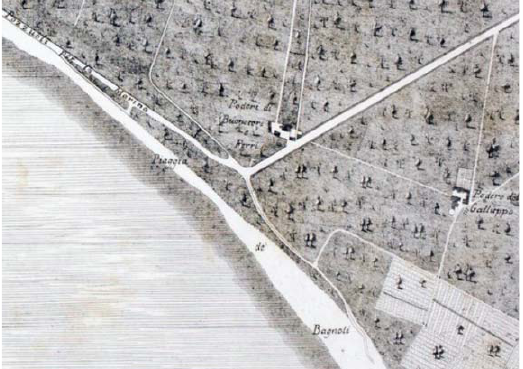
Figure 1. Topographical map of the city of Naples and its outlines (Giovanni Carafa Duke of Noja, Naples, 1775) [6]. Naples, 1775)